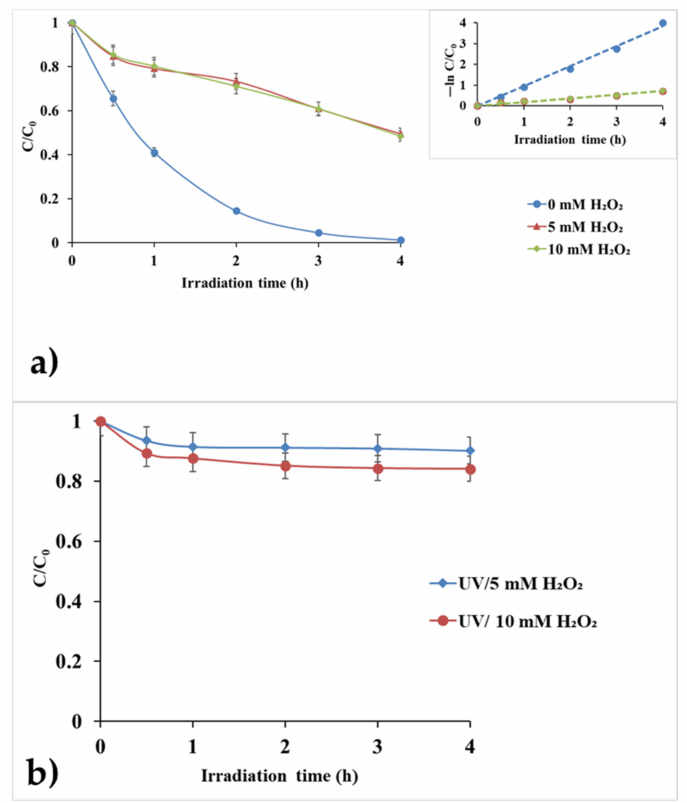
Figure 12. ( a ) Effects of H 2 O 2 on caffeine degradation (1 g Ag-ZnSnO 3 , [CAF] 0 = 10 mg/L, initial pH = 7.5) and its corresponding apparent degradation rate constant (inset), ( b ) UV/5 mM H 2 O 2 , and UV/10 mM H 2 O 2 effects only on 10 mg/L CAF degradation at initial pH =